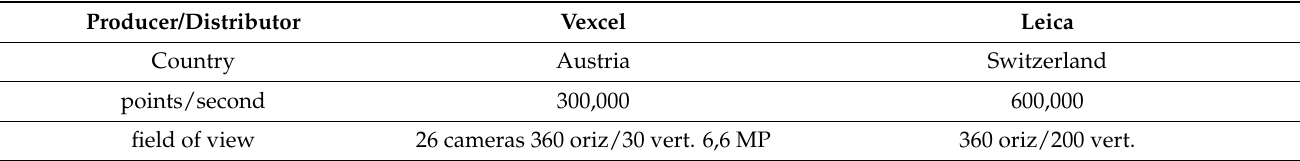
Table 20. Comparing data on mobile scanning systems